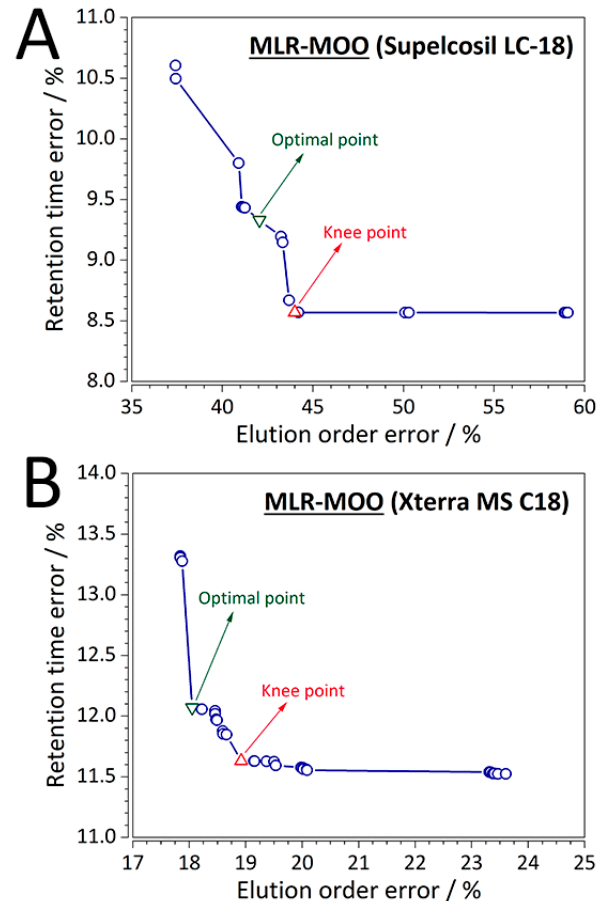
Figure 3. MLR-MOO Pareto front for the ( A ) first case study (Supelcosil LC-18 column, t G = 10 min, T = 35 °C), and for ( B ) the second case study (Xterra MS C18 column, t G = 20 min, T = 40 °C).